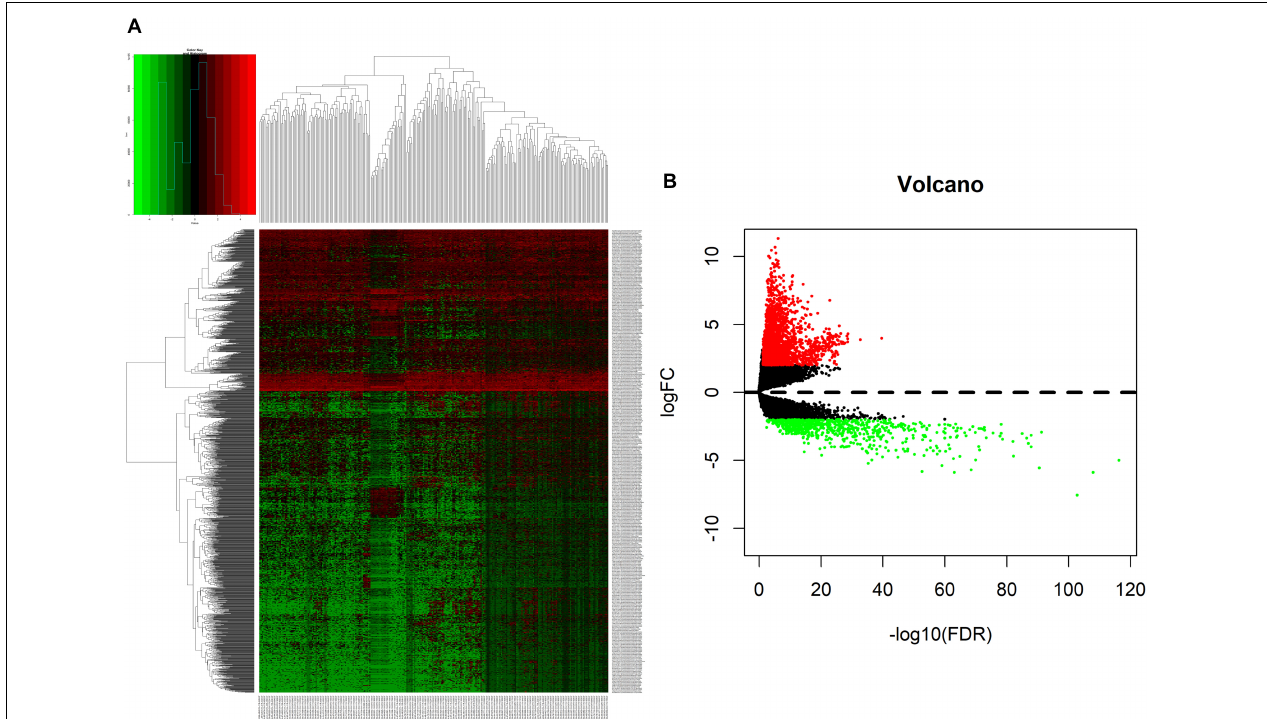
FIGURE 1 | Identification of differentially expressed lncRNAs in LUAD and normal tissues. (A) The heatmap of genome-wide differentially expressed lncRNAs. (B) The volcano plot showed that a total of 1400 upregulated lncRNAs and 245 downregulated lncRNAs were screened out. Green and red represents downregulated and upregulated lncRNAs, respectively. lncRNAs, long non-coding RNAs; LUAD, lung adenocarcinoma.